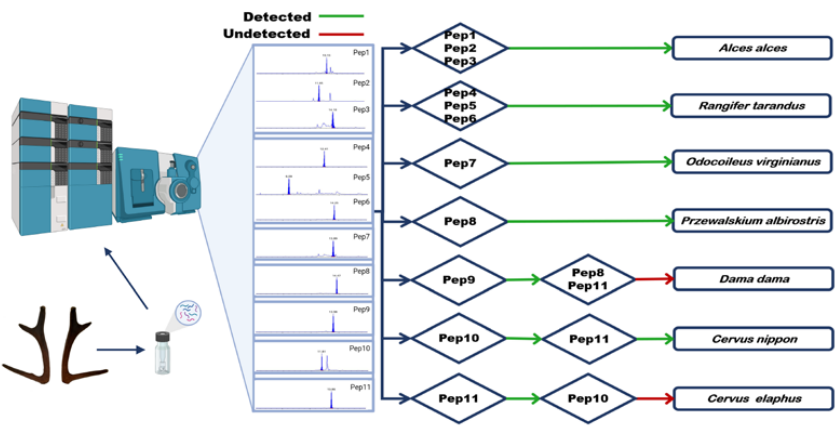
Figure 4. Strategy 1: Simultaneously identifying seven species of deer antler. The deer antlers were processed by method 3.2 and then analyzed by HPLC-Triple Quadrupole MS. The peptide bi- omarkers in the diamond box were used to determine the species; red line means undetected, green line means